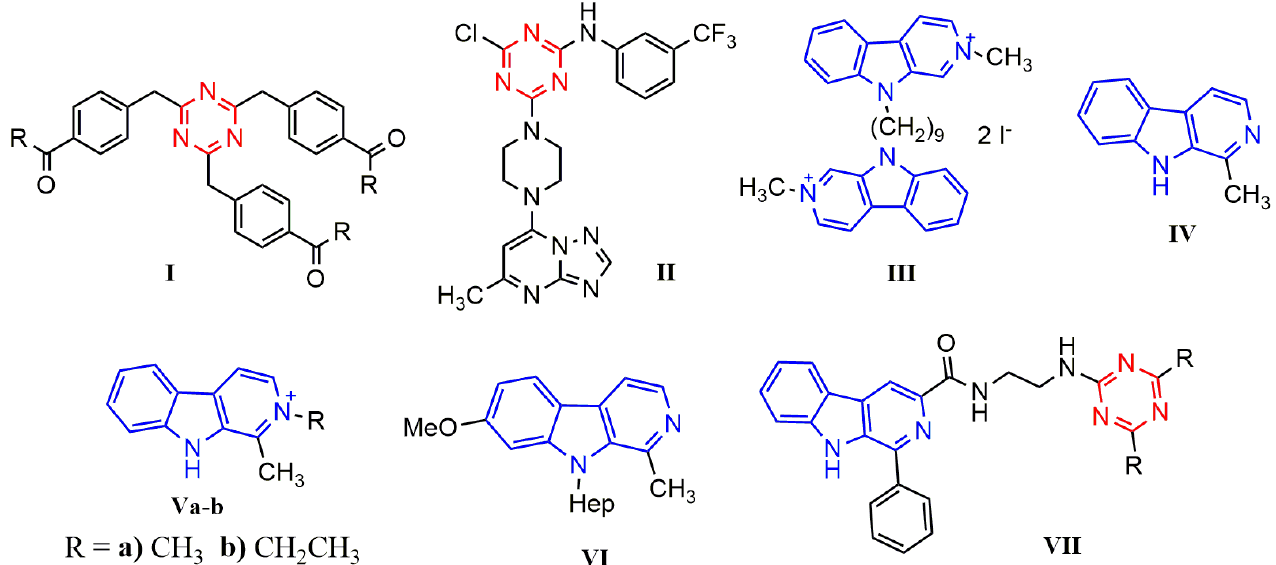
FIGURE 1 - Structures of 1,3,5-triazine ( I and II ) and β-carboline ( III , IV and Va,b ) derivatives with anticholinesterase activity, of DYRK1A inhibitor VI and of β-carboline-1,3,5-triazine hybrid VII